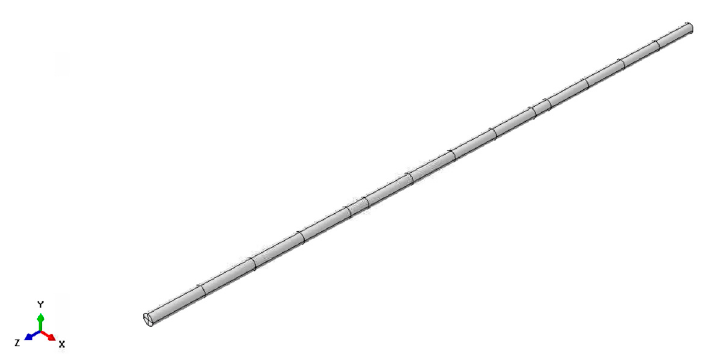
Figure 1. The 28 mm bolt.